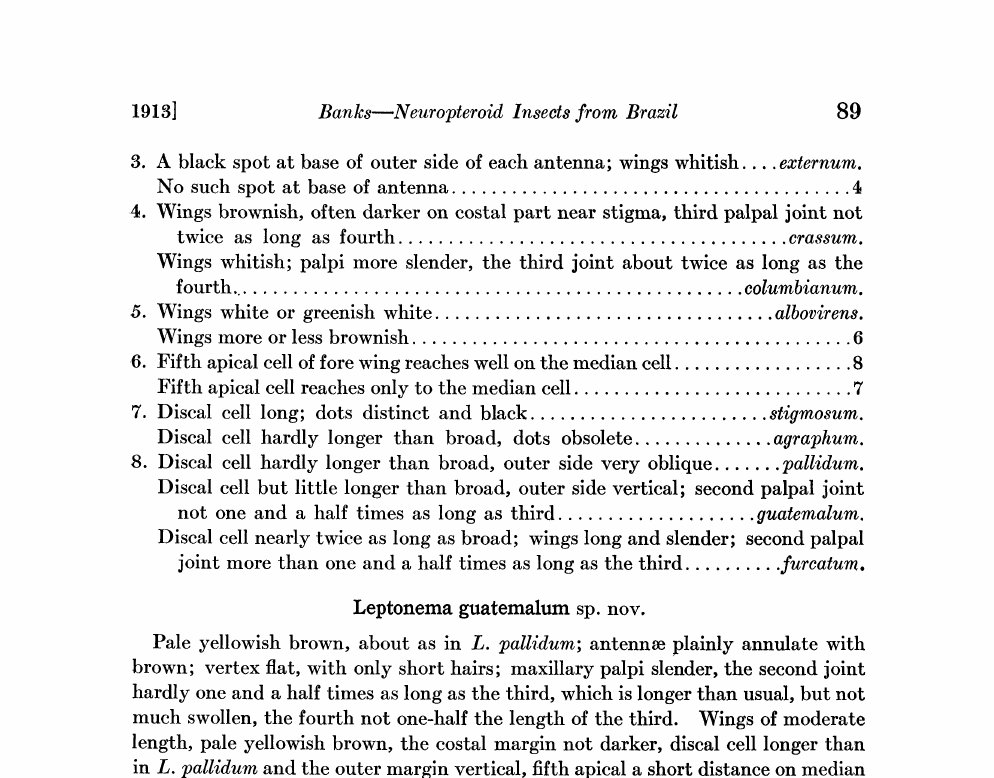
. Figure 1. Leptonema externum wing cells. Notiopsocus simplex